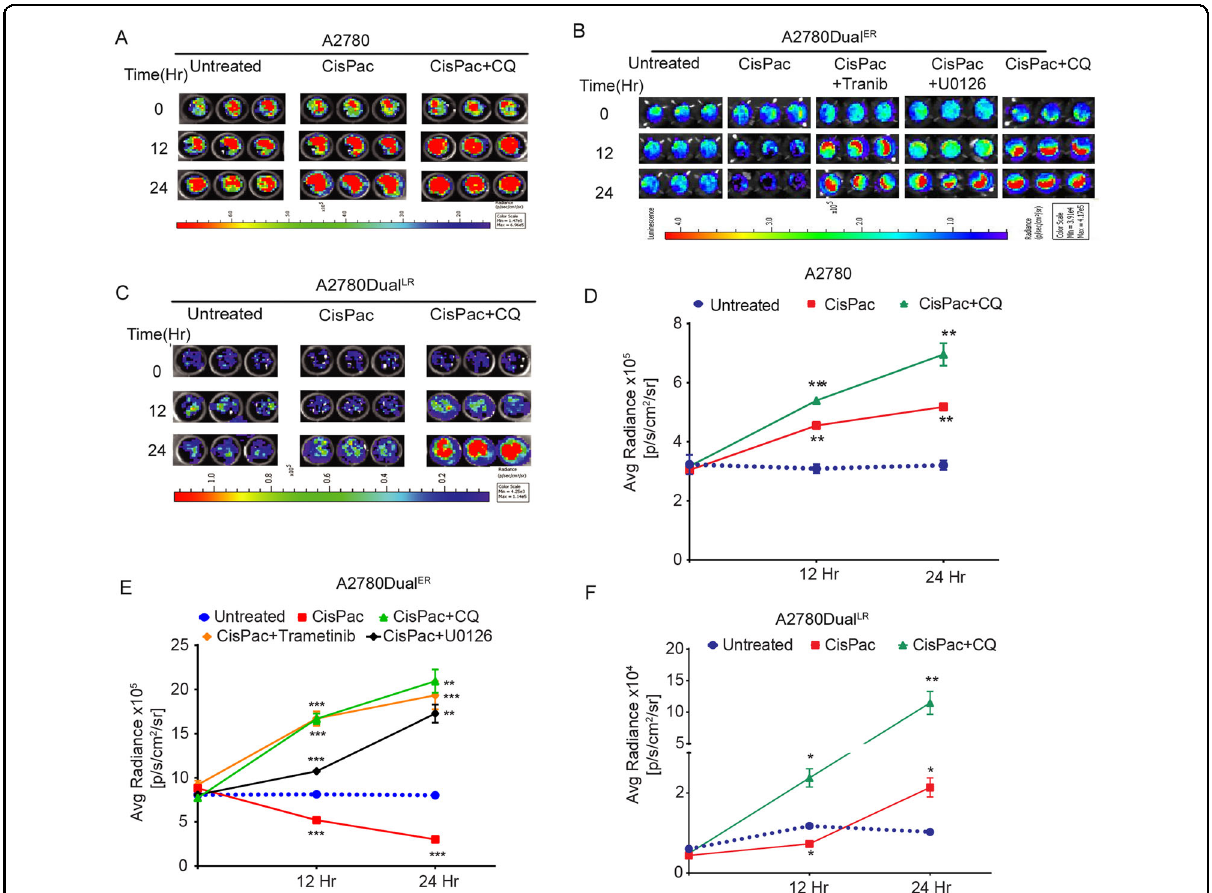
Fig. 5 Live cell imaging of chemotherapy-induced autophagy fl ux utilizing mtFL-p62 construct. A – C Representative live cell images of autophagic fl ux in A2780, A2780Dual ER , and A2780Dual LR cells expressing mtFL-p62 reporter post 12 and 24 h of CisPac treatment alone or with ERK1/2 inhibitor [U0126/Trametinib (Tranib)] or CQ. D – F Quantitation of luciferase signal from live cell imaging showed speci fi c reduction (0.64- and 0.37-fold, respectively) in luciferase activity in A2780Dual ER cells post 12 and 24 h of CisPac treatment, while combinatorial treatment of Trametinib and CisPac at similar time points increased luciferase activity (2.05- and 2.41-fold, respectively) in comparison to respective pretreatment condition (0 h). A similar increase in luciferase activity was also observed in cells treated with combination of U0126/CQ and CisPac. Platinum – taxol treatment for 12 and 24 h increased luciferase activity in A2780 (1.5- and 1.72-fold, respectively) and A2780Dual LR (1.5- and 4.8-fold) cells, which further increased in presence of CQ in both the cell lines (data represent mean ± SEM of at least two independent experiments, ns indicates nonsigni fi cant, * p < 0.05, ** p < 0.005, *** p < 0.0005 as calculated by unpaired t